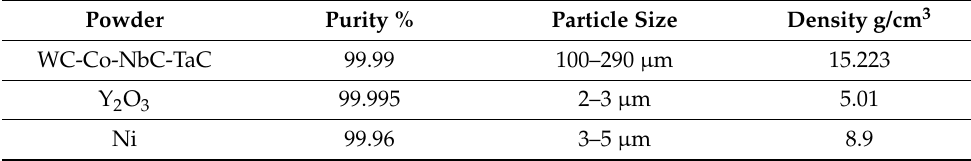
Figure 1. SEM micrographs for the morphology of the raw powders. ( a ) WC-Co-NbC-TaC, ( b ) Y 2 O 3 and ( c ) Ni. Table 1. Properties of the WC-Co-NbC-TaC, Y 2 O 3 and Ni